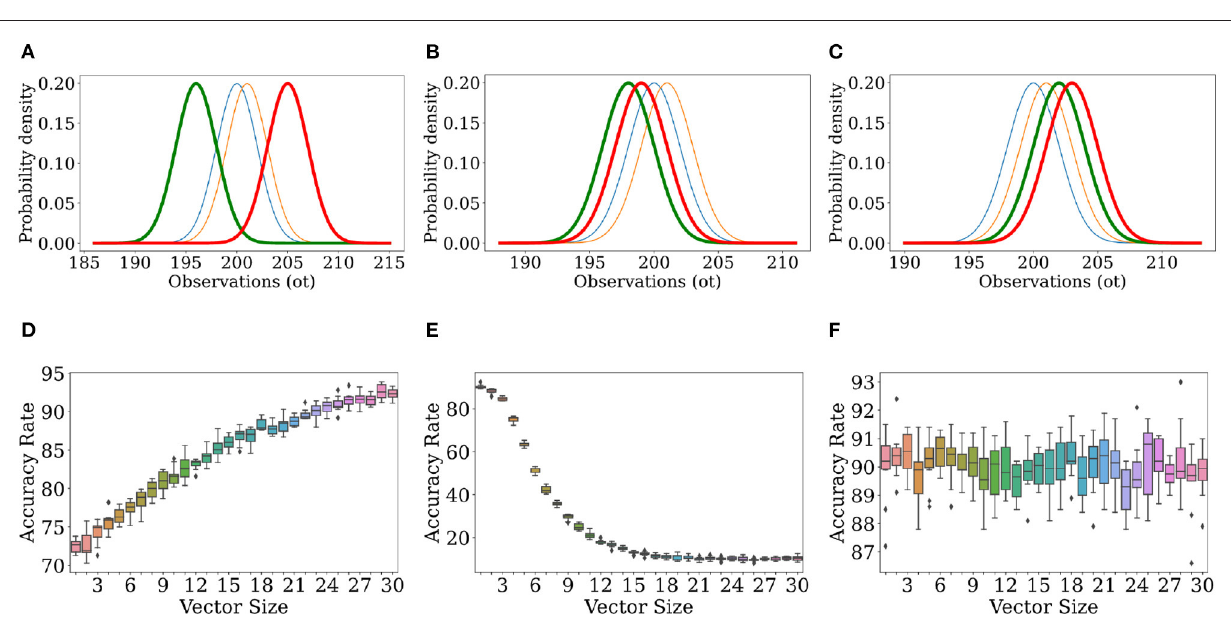
0.2 for the trial whose results are shown in (A) , and f =